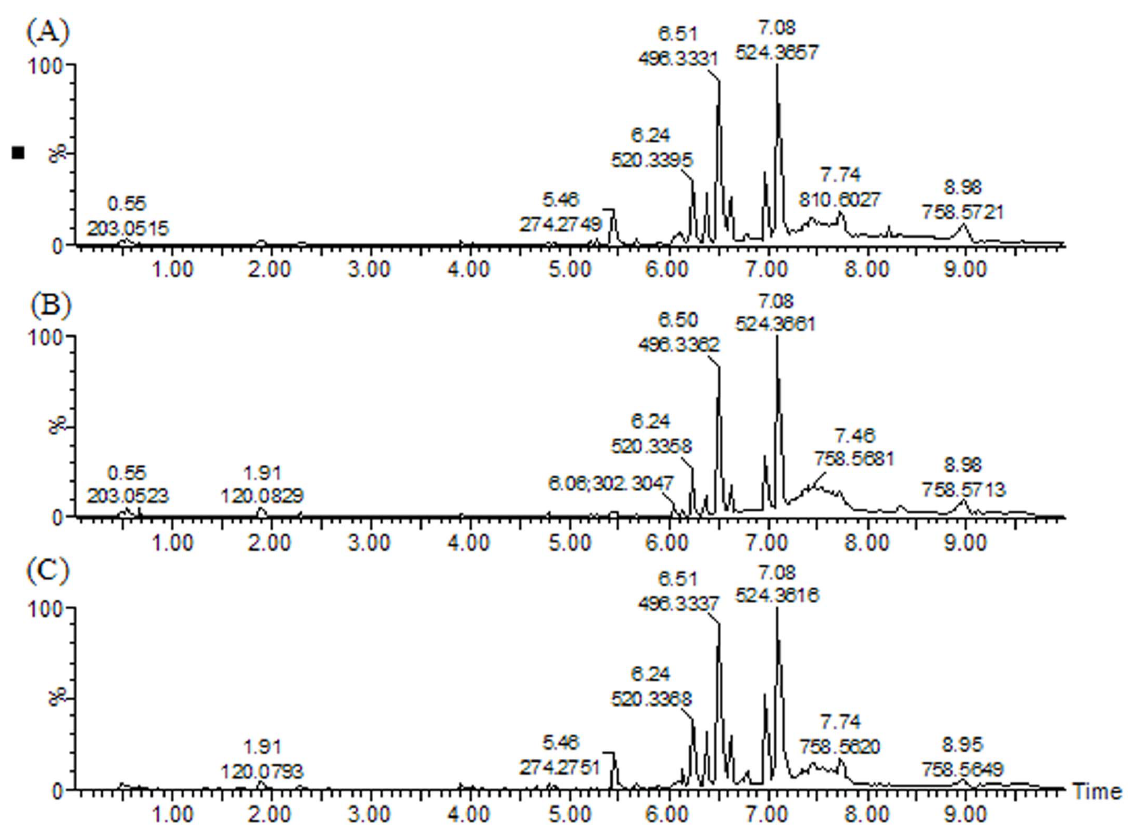
Figure 5. The UPLC-MS base peak intensity (BPI) chromatogram. (A) control group, (B) CKD group and (C) FLP-treated group.